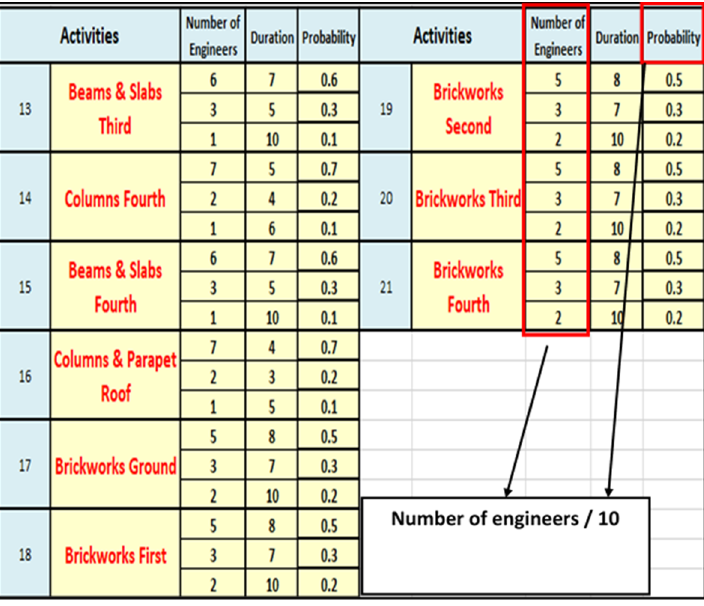
Figure 15. Activities with a DPI of less than 0.80 appeared in green during the simulation. The critical path changed with each update after replacing the baseline durations of the finished activities in each update with the actual ones. The new critical activities were highlighted automatically in the spreadsheet model. Subsequently, the highlighted activities appeared on the 4D building model during the simulation to act as a warning tool for the contractor to avoid future delays, as shown in Figure 16.